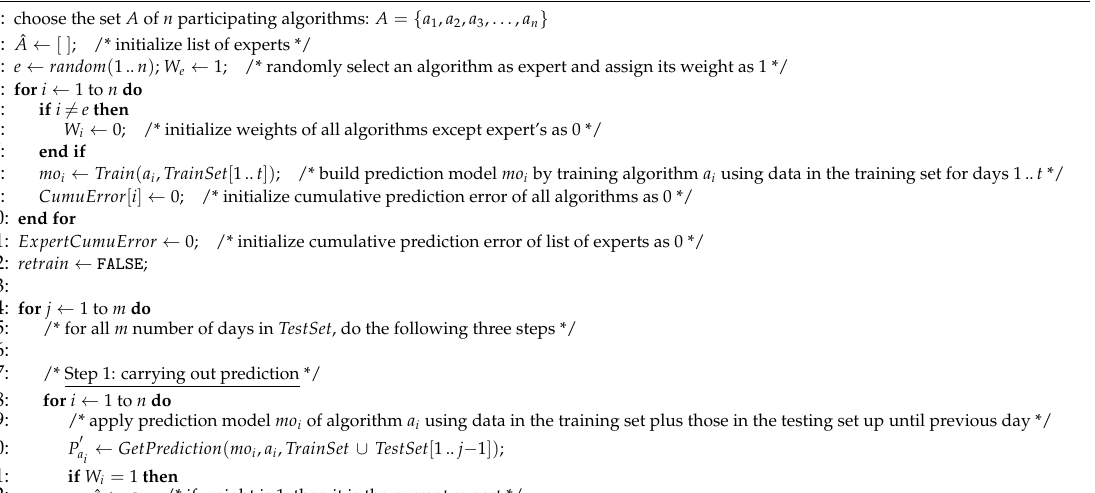
Algorithm 1 Fixed weight method ( TrainSet [ 1 .. t ] , TestSet [ 1 .. m ]